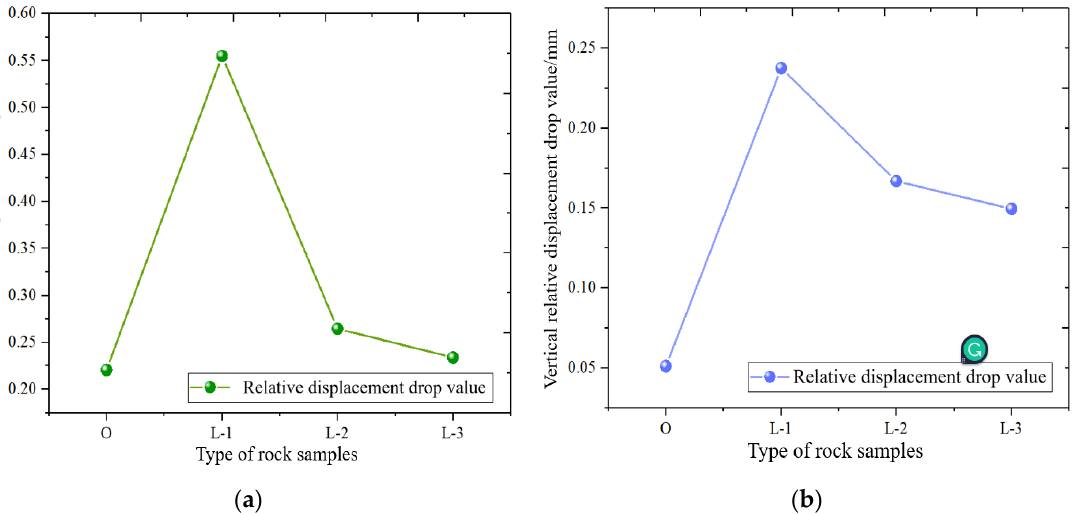
Figure 17. The displacement drops of different types of granite samples in group L. ( a ) The Hori ‐ zontal displacement of samples; ( b ) The vertical displacement of samples.